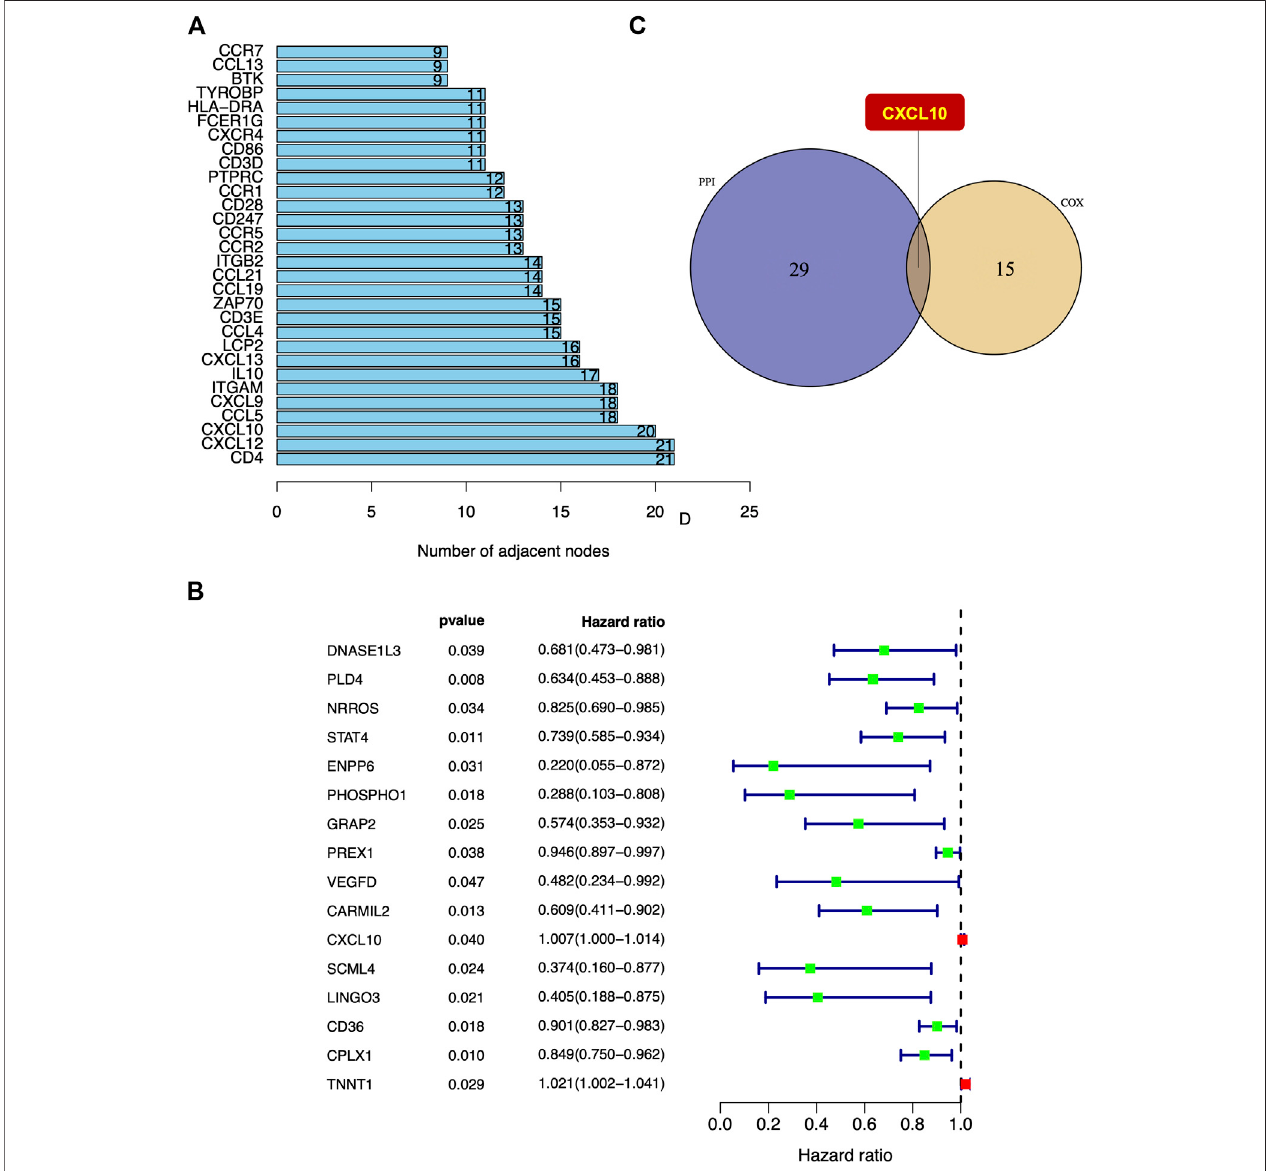
FIGURE 5 | The intersection of PPI network construction and univariate Cox regression analysis. (A) Top 30 differentially expressed genes sorted by quantity of nodes. (B) The top 16 differentially expressed genes in univariate Cox regression analysis with p < 0.05. (C) CXCL10 was the only intersectional gene of PPI network construction and univariate Cox regression